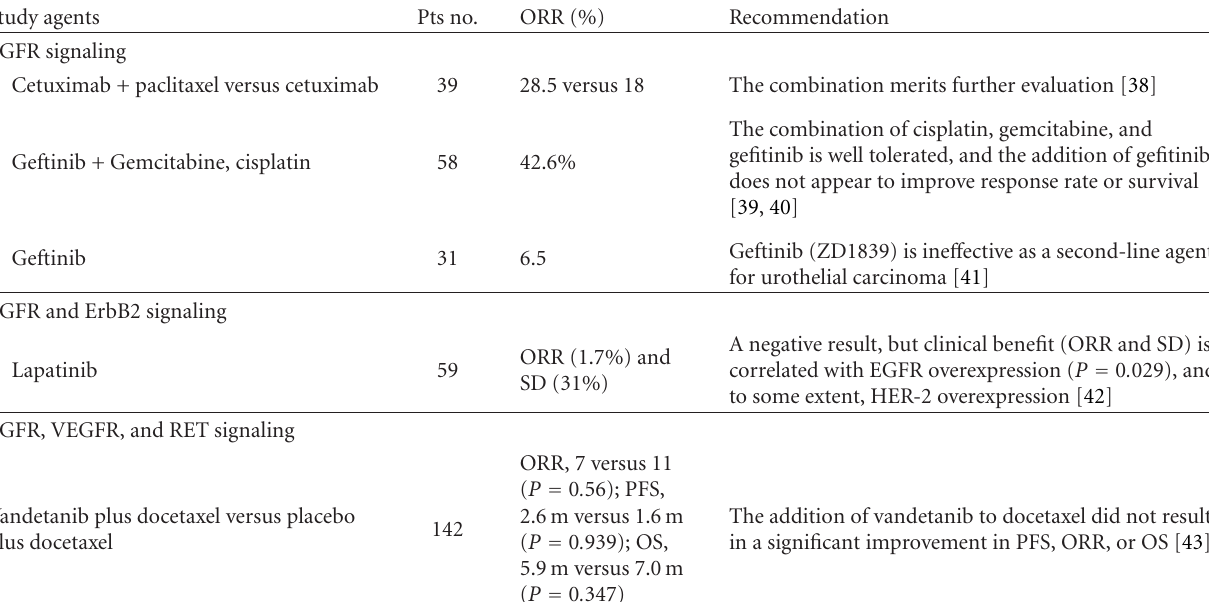
Table 5: The update results of published clinical trials targeting EGFR signaling in urothelial carcinoma patients. Study agents Pts no. ORR (%) Recommendation EGFR signaling Cetuximab + paclitaxel versus cetuximab 28.5 versus